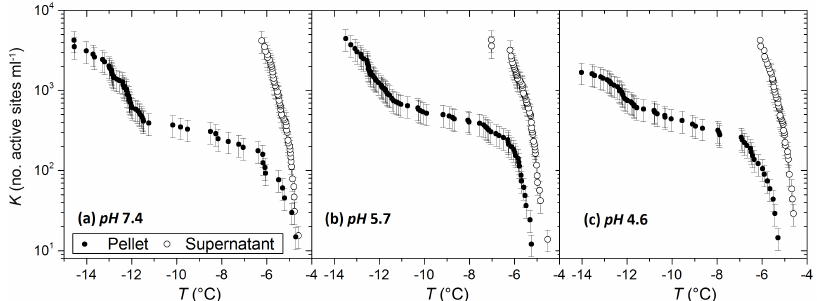
Figure 2. Effect of clay surfaces on fungal P-INPs in solution in the absence of added salts. The ice-nucleating activities of the supernatant and the resuspended clay removed by centrifugation of a suspension of fungal P-INPs and kaolinite are illustrated. The contact time was 2h. Regardless of the initial pH used, ice-nucleating activity is predominantly found in the supernatant, suggesting that adsorption only occurs to a minor extent, if at